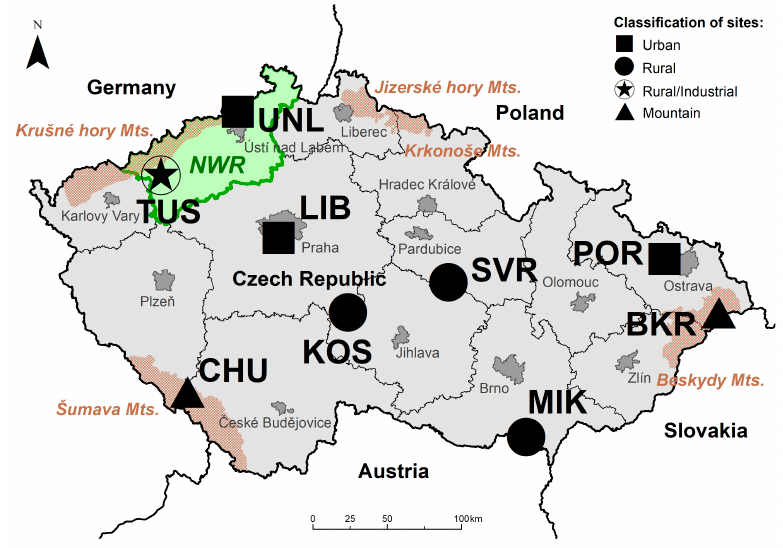
Figure 2. Map showing the areas and places mentioned in this review.